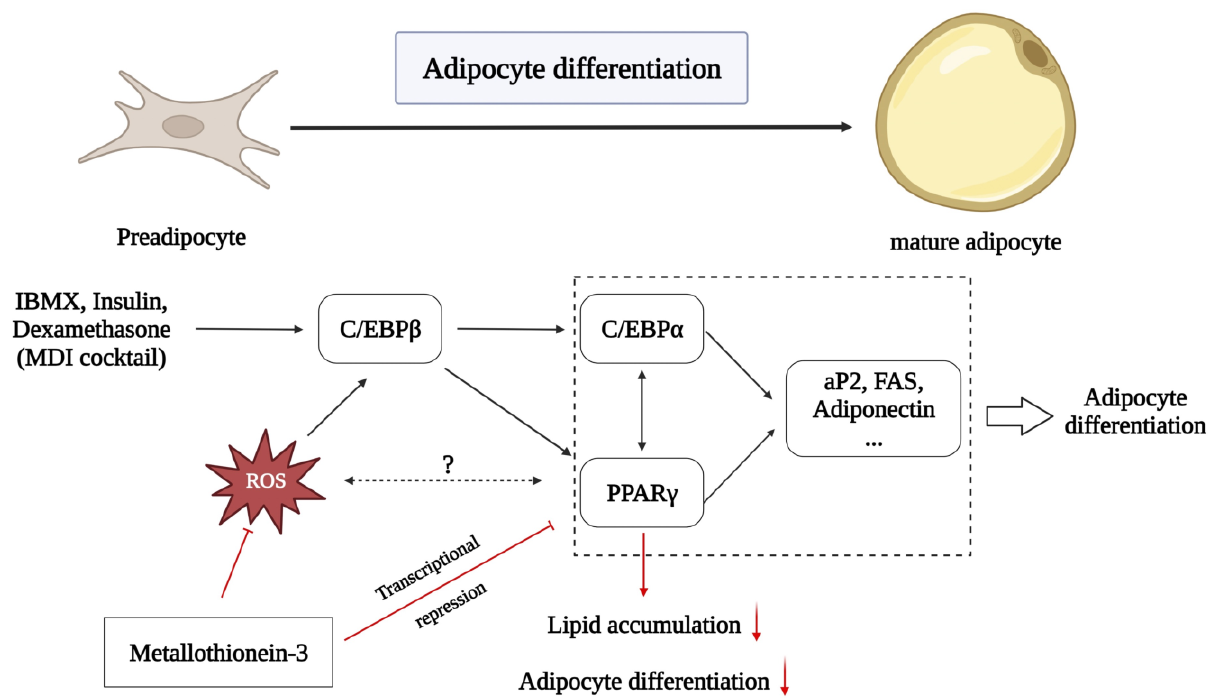
Figure 8. Schematic diagram showing the regulatory effect of MT3 in 3T3-L1 adipocyte differentia- tion. Adipocyte differentiation is a complex physiological process involved in various transcription factors, including the C/EBP family and PPAR γ . On one hand, MT3 can inhibit 3T3-L1 adipocyte differentiation by indirectly suppressing the PPAR γ transcriptional activity. On the other hand, the inhibitory effect of MT3 on 3T3-L1 adipocyte differentiation is largely dependent on reducing ROS levels in the initial adipocyte differentiation. The red arrows represent new findings from our study, while the blank arrows stand for previously known effects.